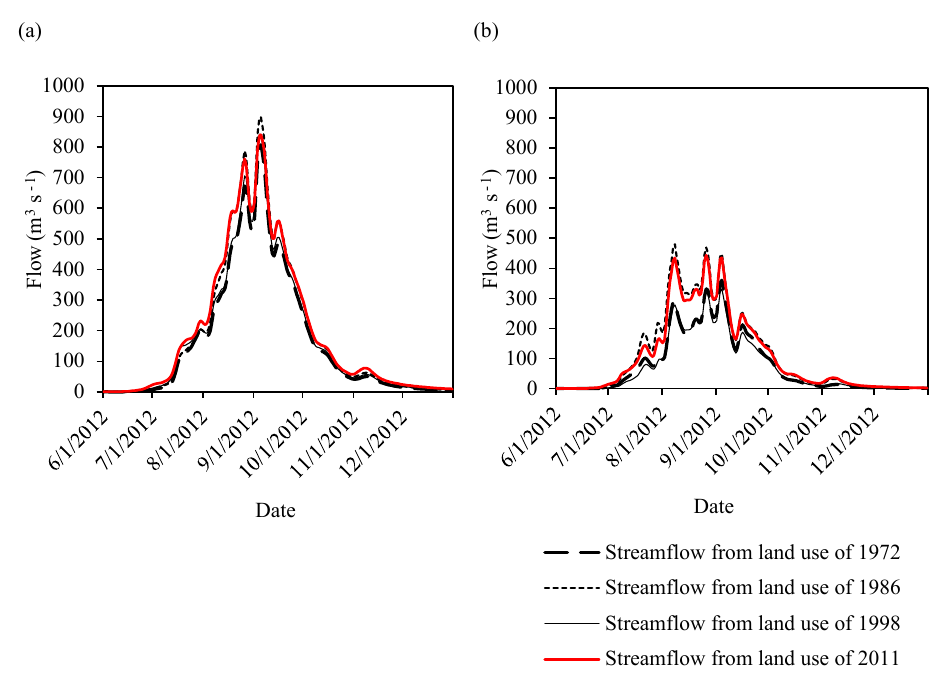
Figure 8. Daily streamflow results from the WFlow model at (a) Al Gewisi station on the Dinder River and (b) Al Hawata station on the Rahad River based on land use from 1972, 1986, 1998 and 2011 for the year 2012 as an example.